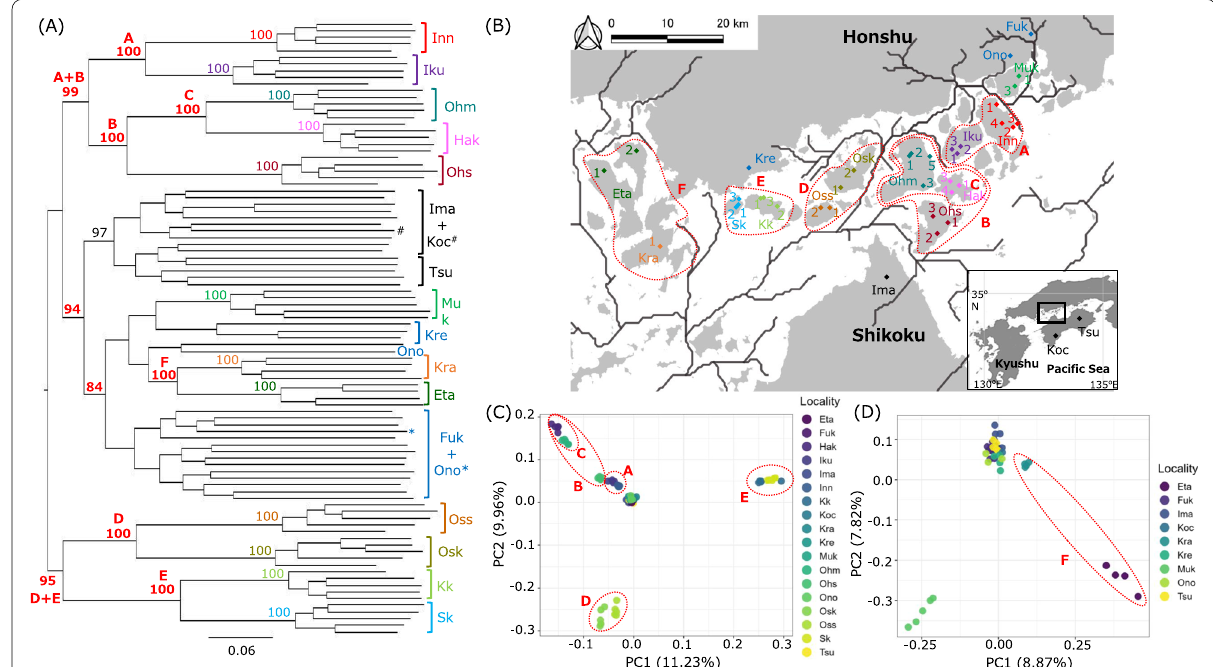
Fig. 1 A Maximum likelihood tree estimated using the GTR G model by Iqtree based on 94,142 single nucleotide polymorphisms detected in + GRAS-Di analysis. Mid-point rooting was used to construct the phylogeny. The numerals above the branches are bootstrap values estimated by ultrafast bootstrap approximation (10,000 replications). These values are only shown for the clades of each island in the Seto Inland Sea and close relationships between these islands A–F . Full information regarding the terminal samples and bootstrap values is shown in Additional File 4. B Sampling localities of the examined individuals and genetic relationships (red enclosures) demarcated on the basis of the phylogenetic tree A . The inset in the lower right corner shows a wider map of western Japan with longitude and latitude information. Letters ( A – F and each locality code) are consistent with the letters in A . The gray lines in the Seto Inland Sea are ancient rivers that are currently submerged, according to estimations by QGIS. The gray lines in Honshu and Shikoku are extant rivers. C Comparisons between PC1 and PC2 obtained by a principal component analysis with the program PLINK1.9. Letters ( A – E and each locality code in the legend) are consistent with the letters in A and B . D The same as for C except for removal of individuals A – E . Letter F and locality code in the legend are consistent with those in A , B , and